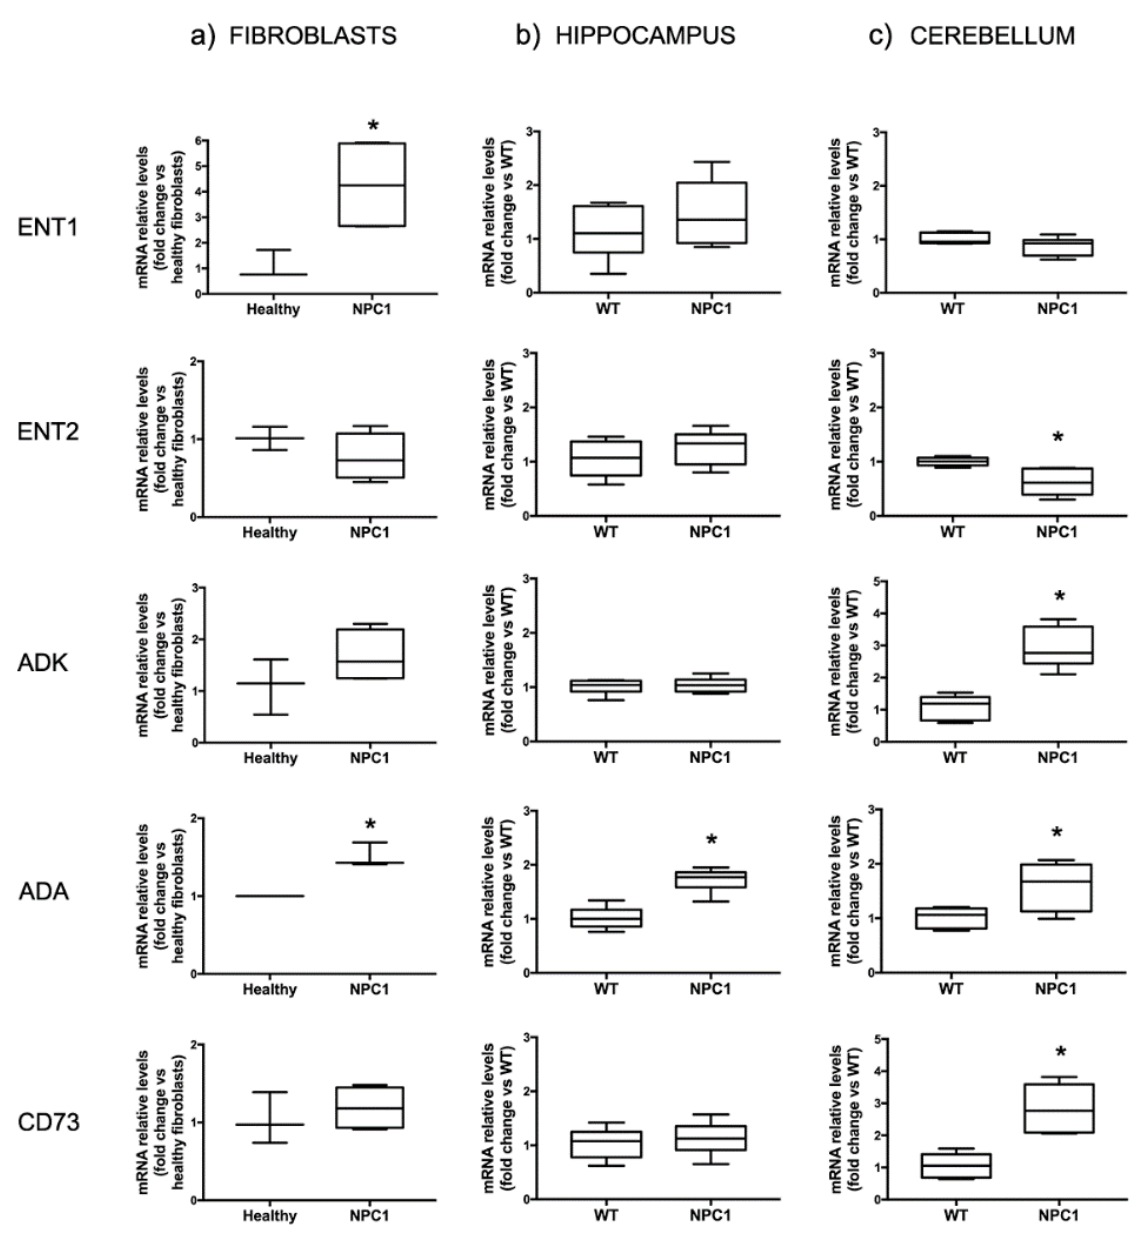
Figure 1. Expression of some major enzymes and transporters involved in the homeostatic control of extracellular adenosine levels. ( a ) mRNA levels of ENT1 and ADA are significantly increased in fibroblasts from NPC1 patients ( n = 4 clones) with respect to levels found in healthy individuals ( n = 3 clones). ( b ) mRNA levels of ADA are increased in the hippocampus of symptomatic NPC1 mice (PND60) with respect to their WT littermates ( n = 6). ( c ) mRNA levels of ADK, ADA and CD73 are increased in the cerebellum of symptomatic NPC1 mice (PND60) with respect to their WT littermates ( n = 6 animals), while ENT2 expression is decreased. Data are expressed as box-plots (whiskers from min to max values). * p < 0.05 after two-tailed Student’s t